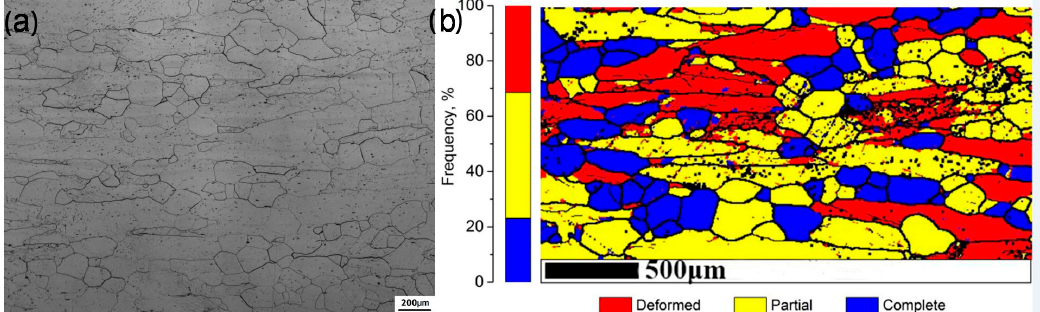
Figure 11. ( a ) microstructure; ( b ) recrystallized fractions of Domain 2 at the true strain of 0.7. Domain 3 also indicates high power dissipation efficiency (0.4 < η < 0.55) and low instability ( ξ